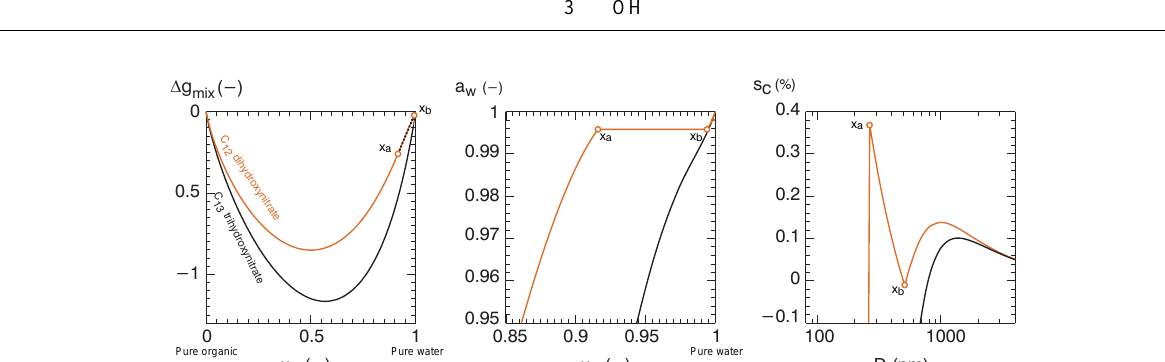
Figure 1. Modeled (cid:49)g mix (left), water activity (middle), and Köhler curves (right) for C 12 dihydroxy nitrate and C 13 trihydroxy nitrate (see Table 1). Open circles denote the mole fractions x a and x b that correspond to the envelope of compositions where liquid–liquid phase separation is predicted for the C 12 dihydroxy